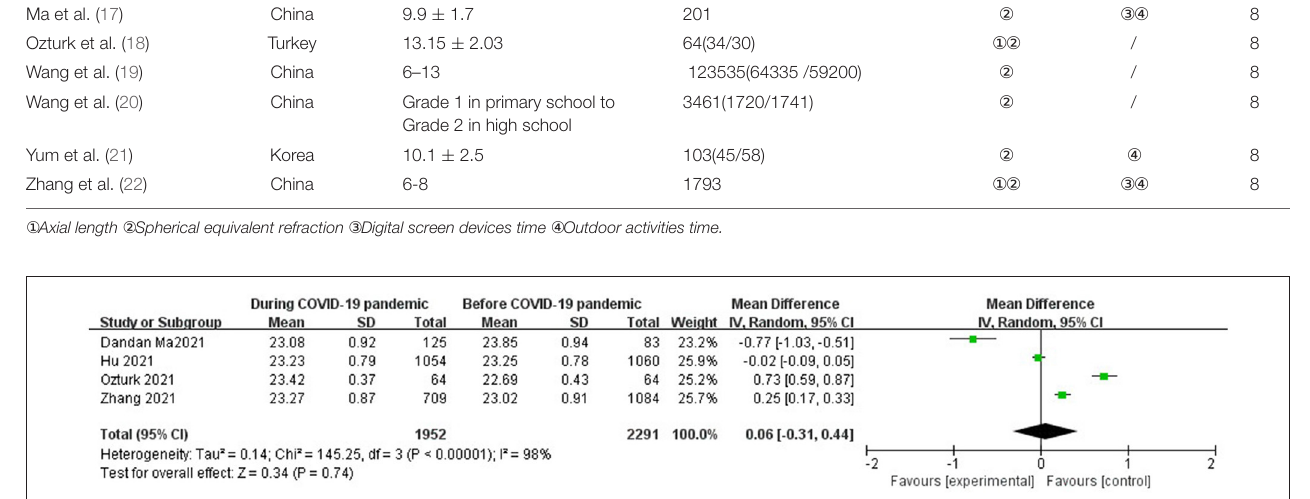
FIGURE 2 | Forest plots for comparison of axial length between COVID-19 pandemic and before it.